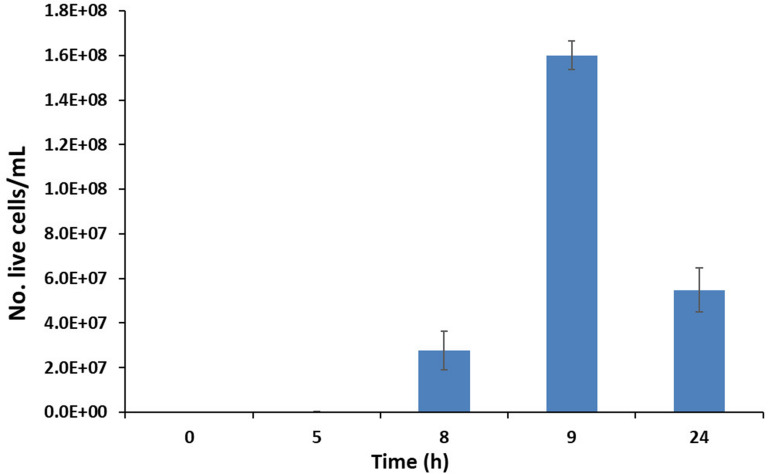
Number of live cells (No. live cells/mL) evaluated using direct fluorescence methods at different experimental times (0–24 h). The vertical bars represent the standard errors.